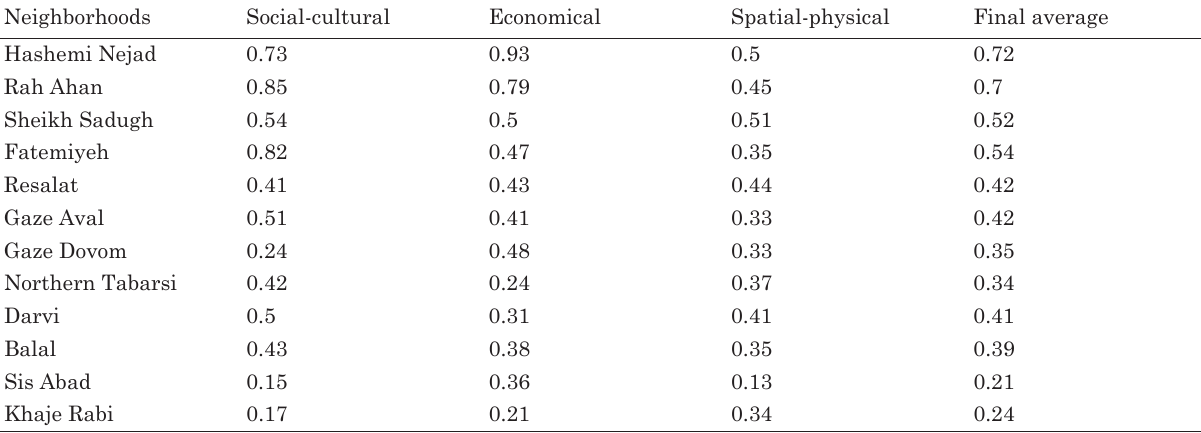
Table 3. Nomination of neighborhood developmentlevel in district three of Mashhad with the MORRIS model